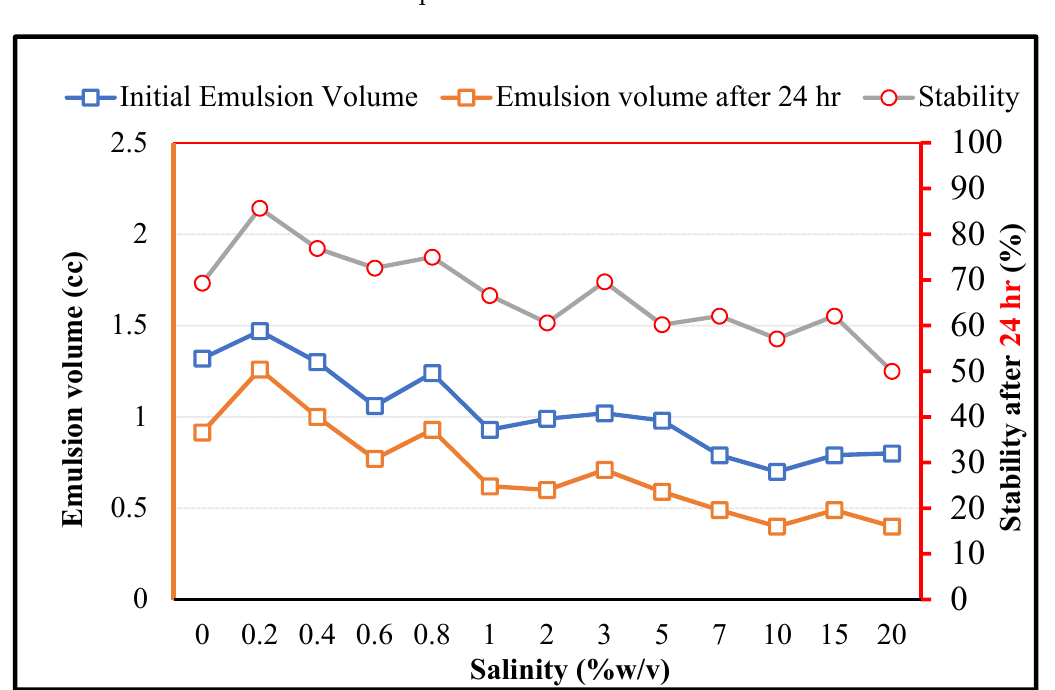
Figure 6. The impact of salinity on the crude oil in brine emulsions stabilized by RAG1 bacteria cells (1500 ppm).